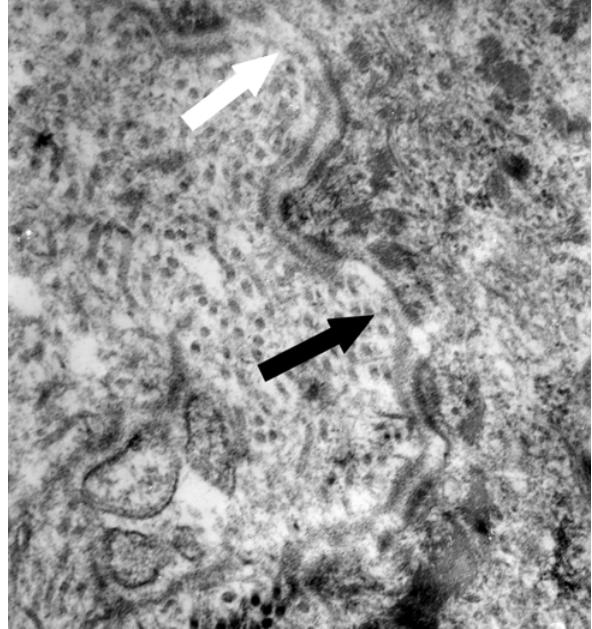
FIGURE 7- TEM micrograph showing disrupted (white arrow) and discontinuous (black arrow) basement membrane